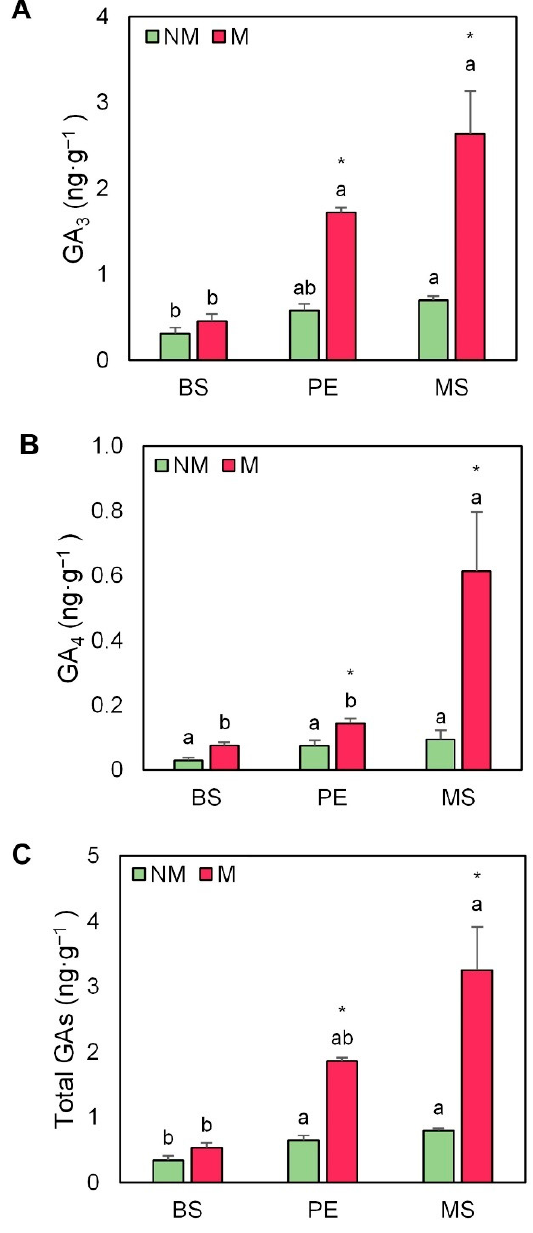
Figure 5. ( A ) Gibberellin A3 (GA3), ( B ) gibberellin A4 (GA4), and ( C ) total gibberellin (GAs) concentra- tions in leaves of escarole plants of the commercial variety “Bekele” cultivated under non-mycorrhizal (NM) and mycorrhizal (M) conditions and covered or not with mulching treatments. Bars show the means of five plants ± standard error. Different letters show significant differences among mulching treatments while the asterisk (*) indicates significant differences due to AMF inoculation within each mulching treatment according to Tukey’s and t -tests ( p ≤ 0.05). Abbreviations used: bare soil (BS), polyethylene mulch (PE), and mushroom substrate-based hydromulch